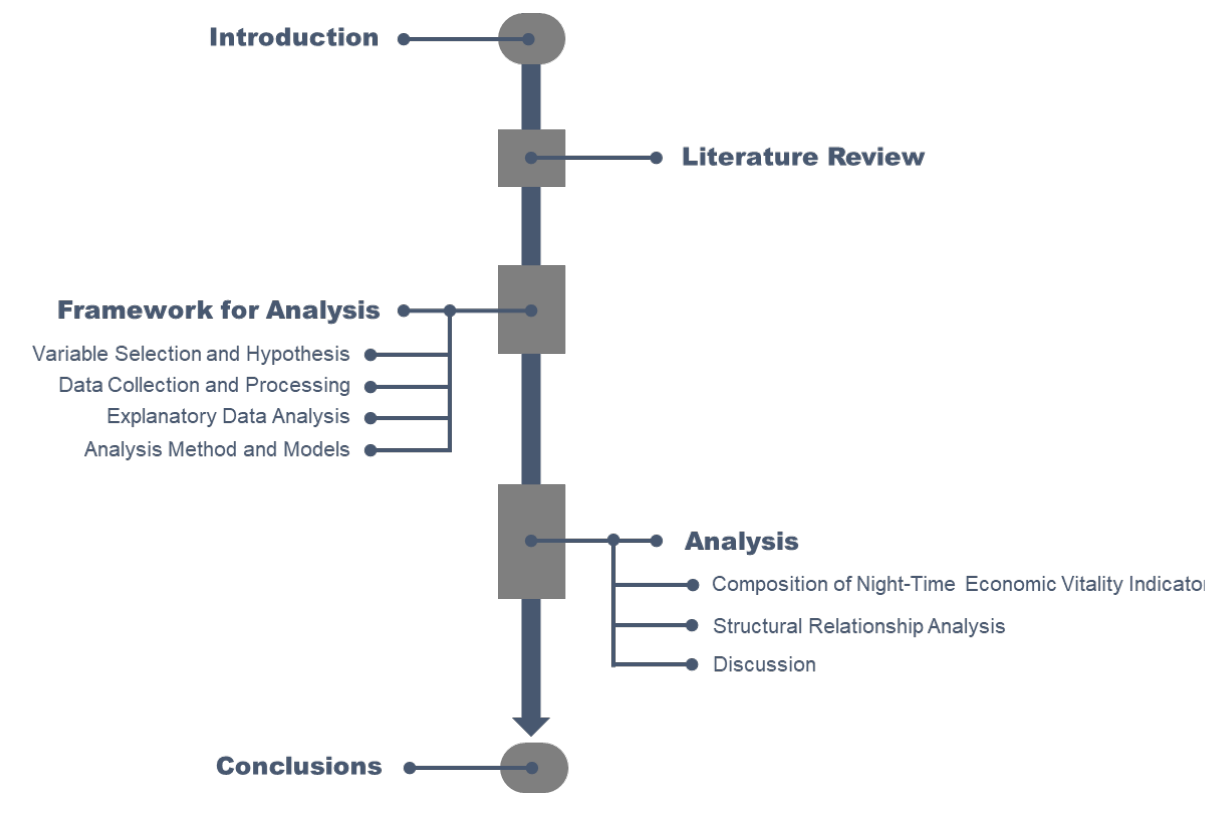
Figure 1. Flowchart of the study.